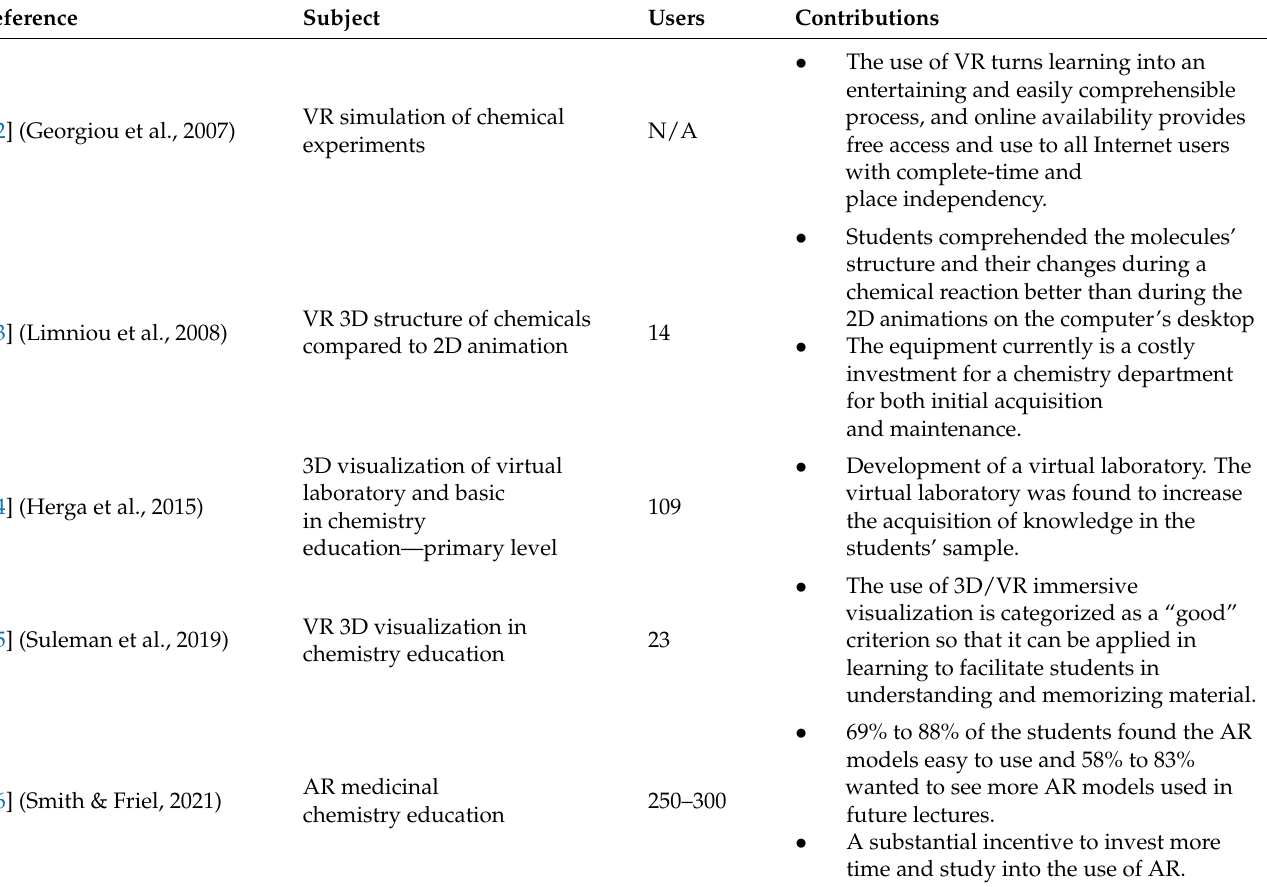
Table 1. Relevant studies in chemistry and medical chemistry presenting VR/AR educational